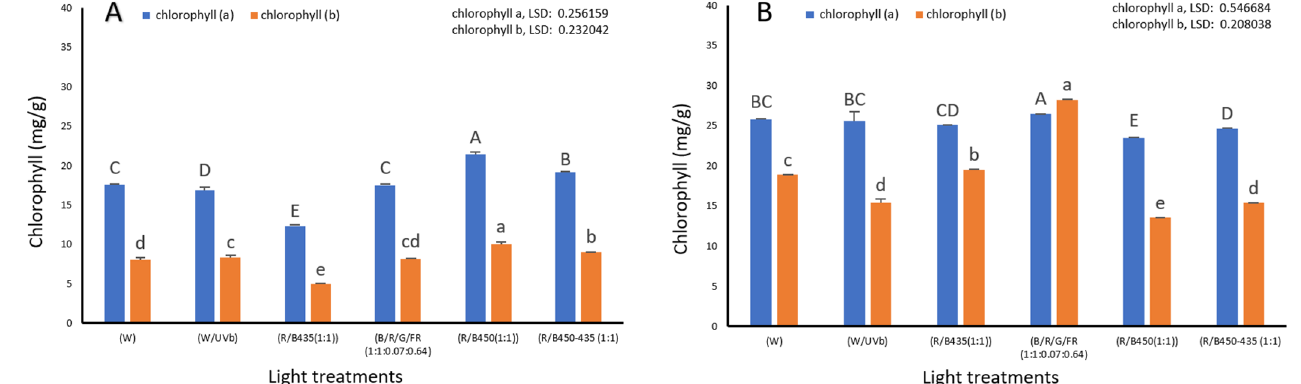
Figure 6. The impact of LED light spectrum on chlorophyll content of ( A ) blue lettuce and ( B ) red lettuce. Letters indicate significant differences ( p < 0.05) between treatments within each experiment (capital letters for chlorophyll ( a ) and small letters for chlorophyll ( b )).